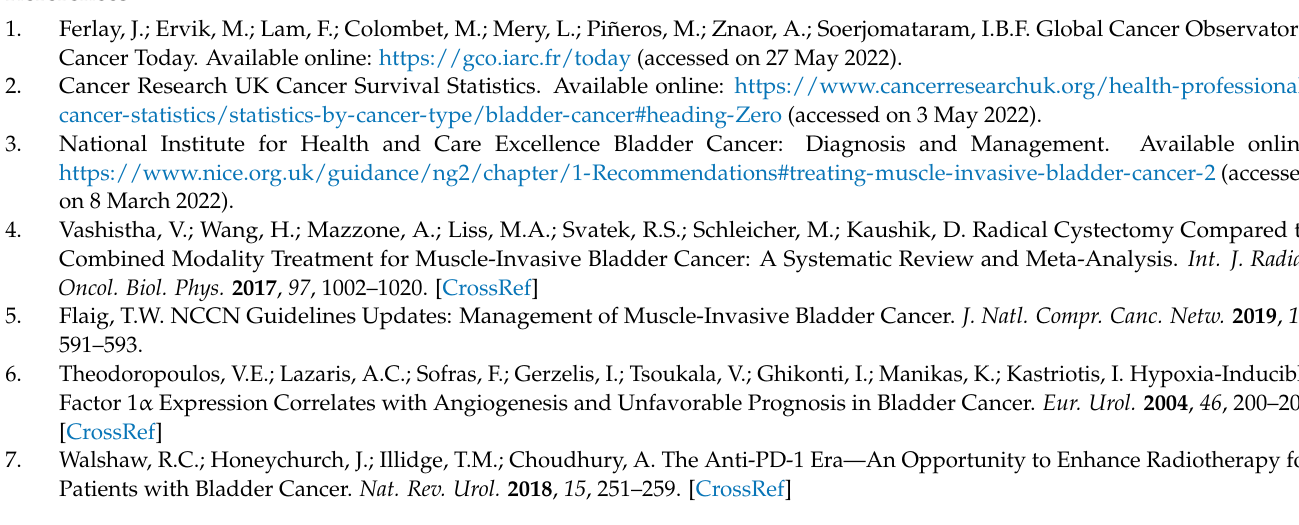
co-localisation representing Treg cells. Figure S2. BCON clinical trial consort flowchart. TMA stands for Tissue Microarray, FFPE for Formalin Fixed Paraffin Embedded. Figure S3. Kaplan–Meier survival curve showing the non-linearity between overall survival and percent of CD8 T cells. The percent of CD8 T cells was stratified into quantiles and a Kaplan–Meier curve plotted using the “survival” package in R looking at overall survival ( n = 116). Figure S4. Boxplots showing the association between molecular subtype and the percent of each marker. Molecular subtypes were assigned using “consensusMIBC” package in R and correlated with the percent of each marker ( n = 80; A–D). Subtypes were then grouped into luminal (LumP, LumU, LumNS), basal (basal/squamous and stroma-rich) and NE-like subtypes were excluded and correlated with the percent of each marker ( n = 75; E–H). Statistical tests are Wilcox tests with p values represented as follows: ns = not significant, * < 0.05, ** < 0.01, *** < 0.001. Table S1. Multiplex IHC reagent dilutions. Table S2. Table of characteristics comparing the experimental cohort and overall trial cohort. Table S3. The differences in range (min, max), mean and median population densities for each marker ( n = 116). Table S4. Table of characteristics for RT and RT+CON cohort arms and CD8 high and low cohort arms with overall cohort. p values are t-tests calculated by R. Table S5. Median population density expressed as a percentage of positive cells of total cells for all cores of each patient. p value represents a Wilcox test between CA9 status and each